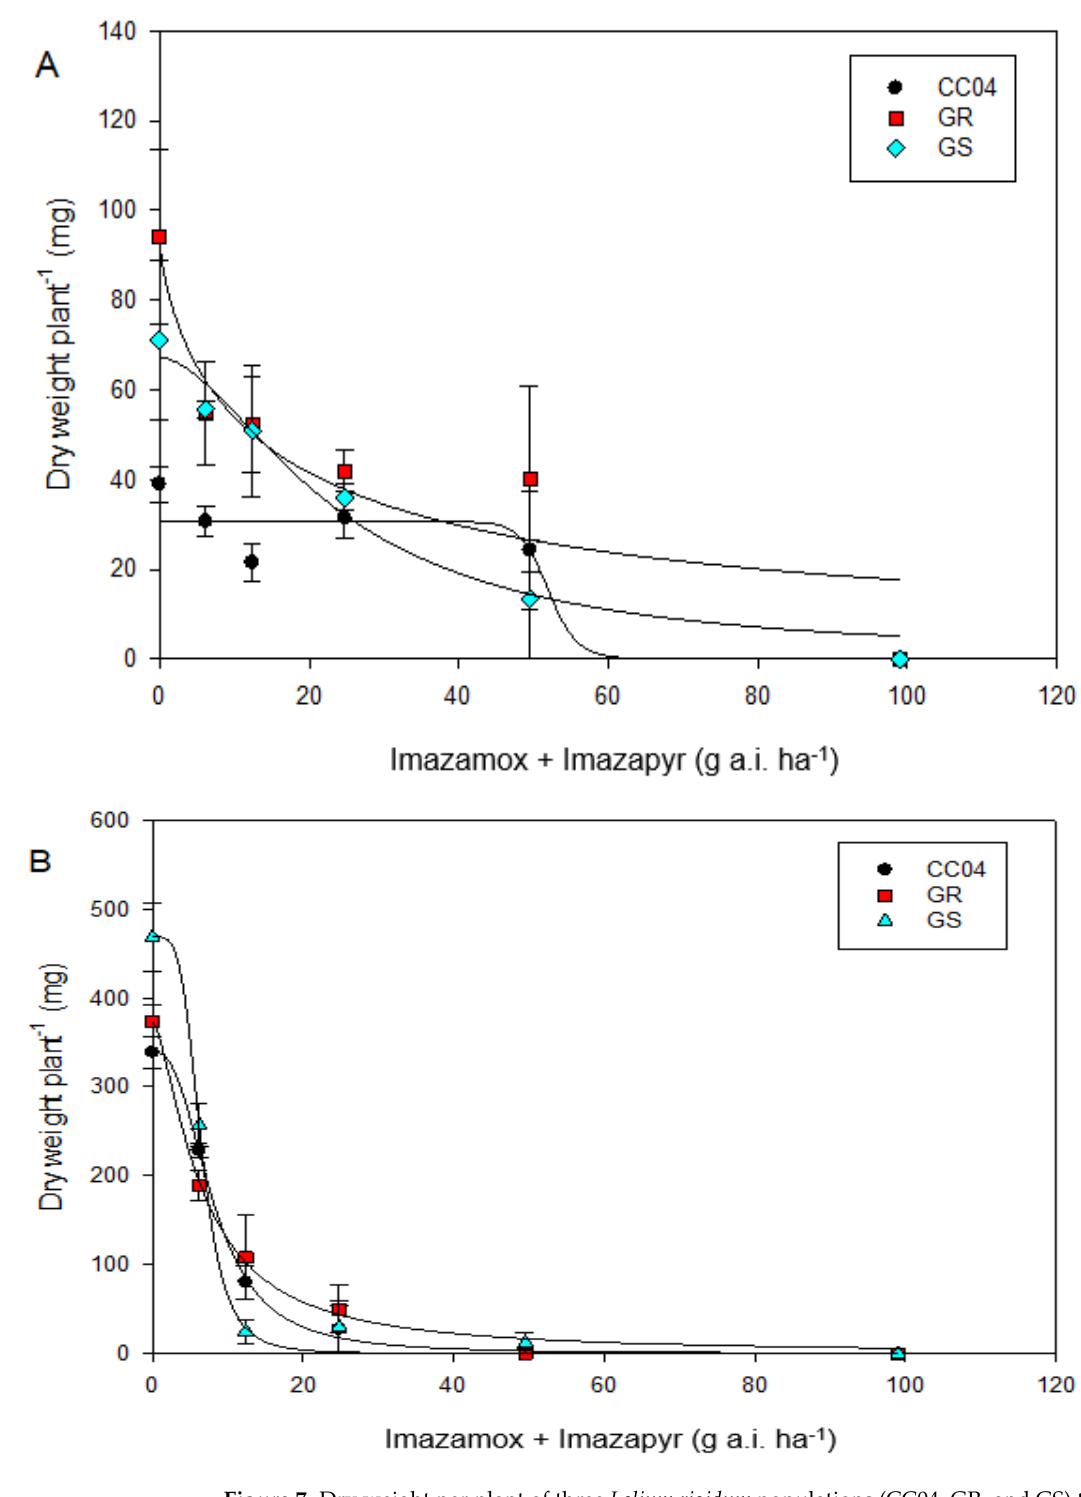
Figure 7. Dry weight per plant of three Lolium rigidum populations (CC04, GR, and GS) to six rates of imazamox + imazapyr in ( A ) 2019 and ( B ) 2021. Data are presented as the average dry weight per plant and error bars represent the standard error of the mean.